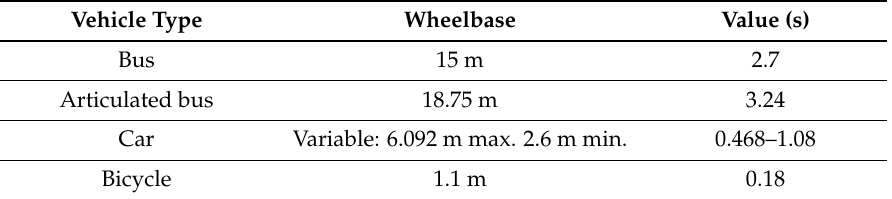
Table 3. Values of timers T1 and T2, depending on vehicle type, at a constant speed of 20